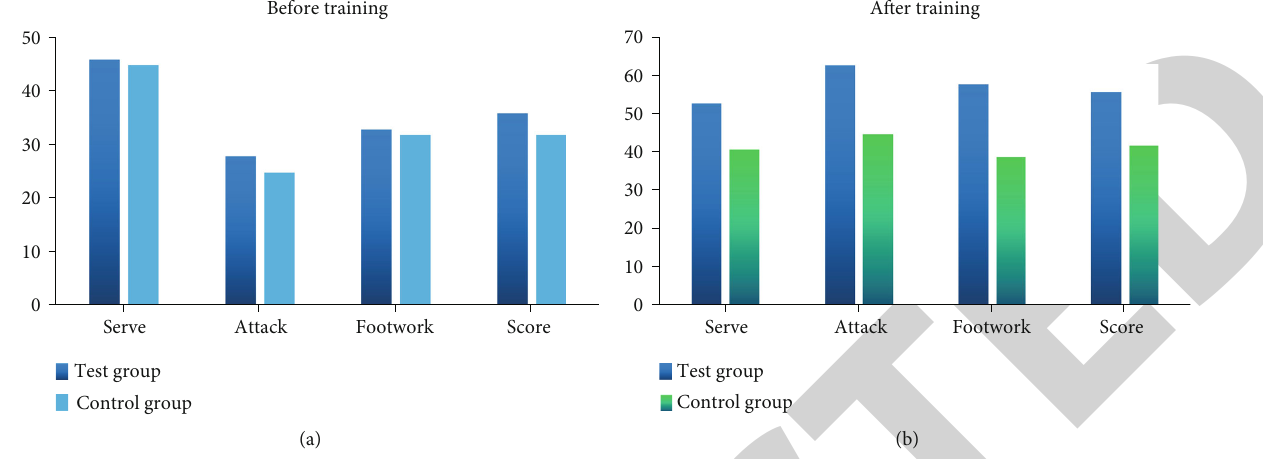
Figure 8: Comparison of various values between the test group and the control group